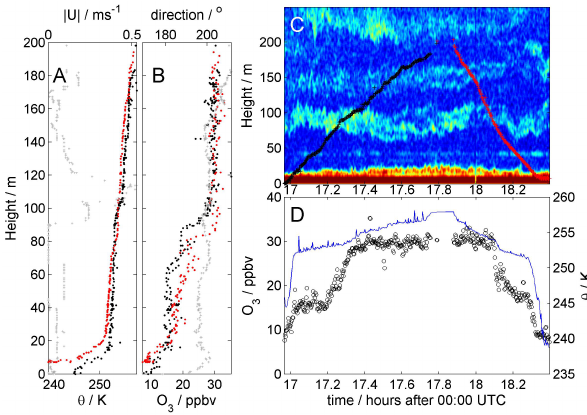
Fig. 5. As for Fig. 3, but now for 25 August 2007. Please note the difference in scales.